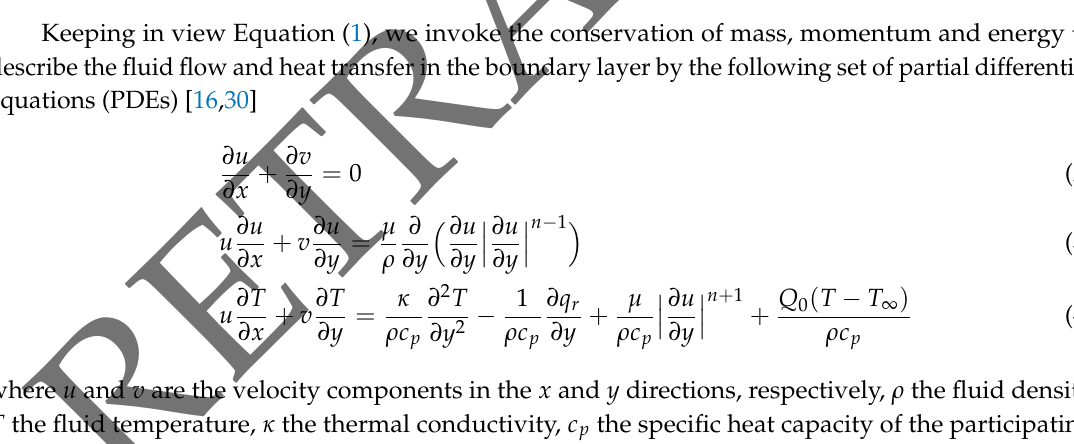
Figure 1. Physical model and coordinate